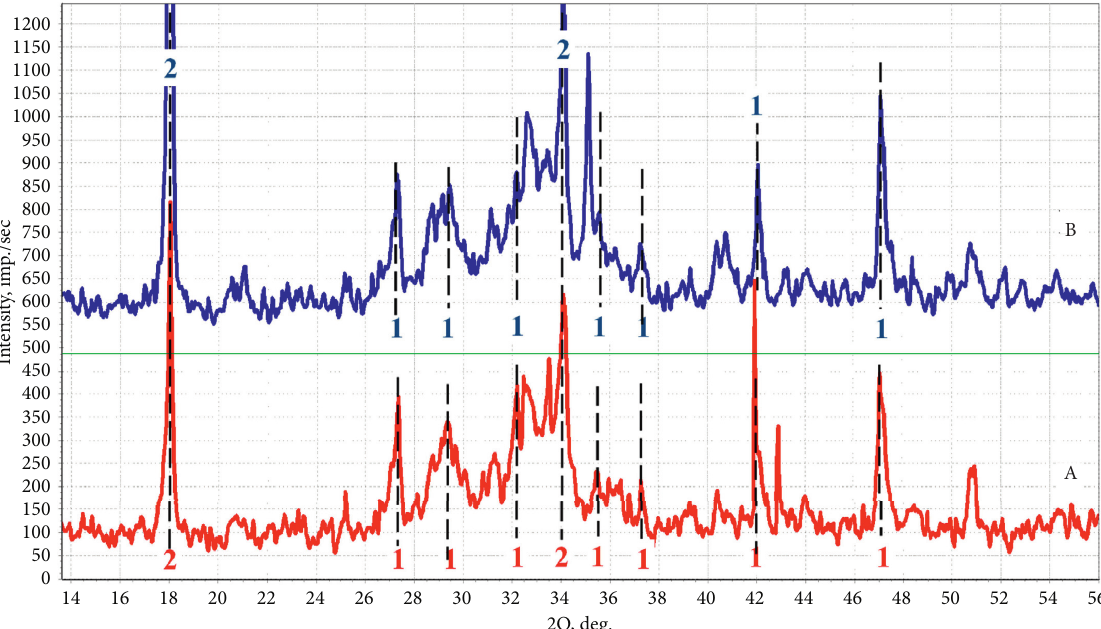
Figure 11: Diffraction patterns of cement paste (A) and cement paste in a composite based on a modified shot of titanium hydride (B), subjected to c -irradiation dose D � 1MGy: 1-2CaO · SiO 2 · O 2 P ; 2-Ca(OH) 2 .